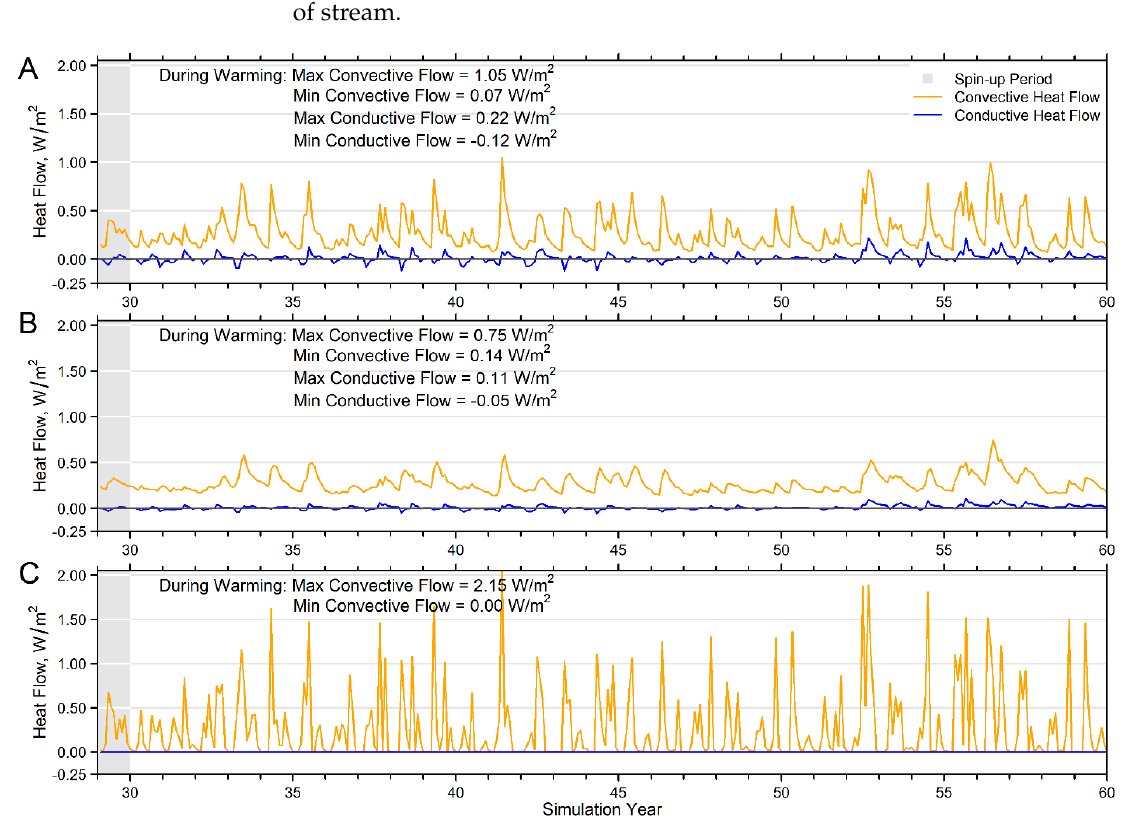
Figure 8. Recharge heat flow components (W/m 2 ) averaged monthly over the model domain for the ( A ) MID_TRENDED, ( B ) HI_TRENDED, and ( C ) MID_TRENDED (riparian area only) simulations. Heat flow components are shown for conduction and convection. Dispersive heat flow is negligible. Warming period begins in Simulation Year 30.